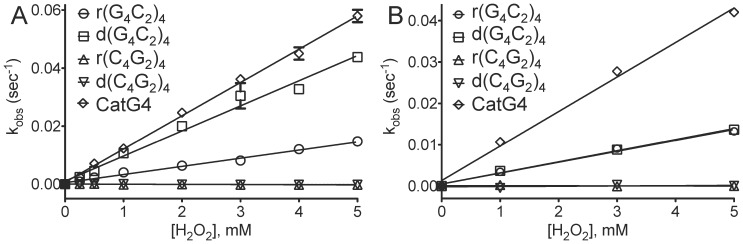

c9orf72 repeat DNA And RNA catalyze peroxidase reactions.kobs values for peroxidation reactions made up of 10 µM DNA/RNA, 0.1 µM heme, 1 mM ABTS and varied hydrogen peroxide concentrations from 0-5 mM. Panel A reactions were carried out in NH4-HEPES buffer (40 mM HEPES, pH 8.0, 20 mM potassium chloride, 1% N,N-dimethylformamide, 0.05% Triton X-100); and, Panel B reactions were carried out in Tris buffer (25 mM Tris-Cl, pH 8.0, 20 mM potassium chloride, 1% N,N-dimethylformamide, 0.05% Triton X-100).